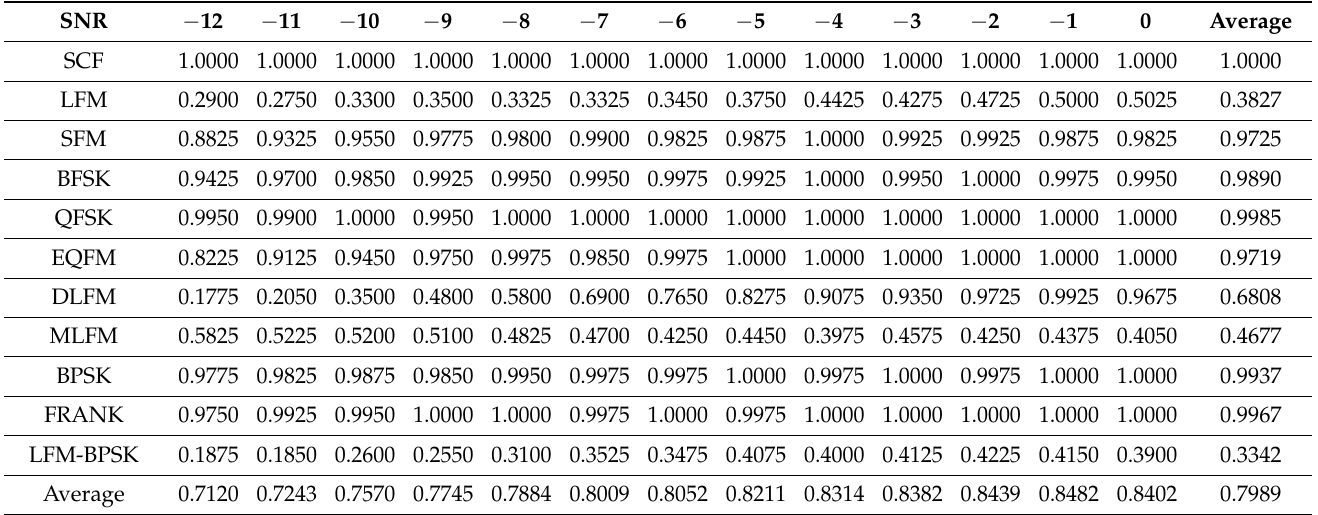
Table A14. Semi-supervised classification results with the datasets in Situation Dataset 4 without self-paced data augmentation ( T cycle = 50, NUM =